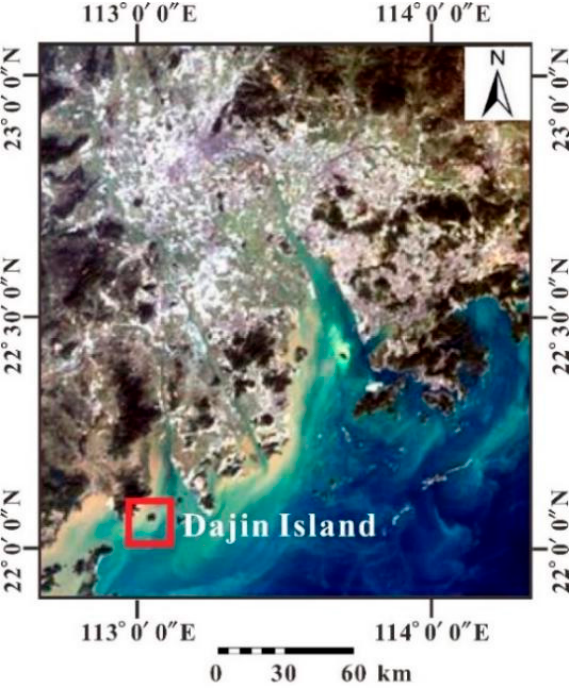
Figure 3. The tailored MODIS image which covers the Pearl River Estuary.